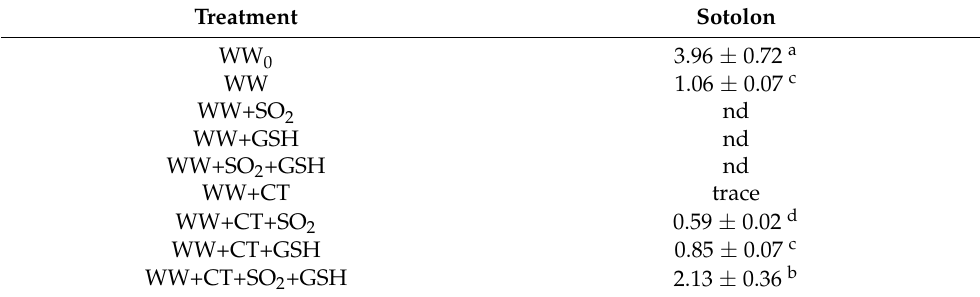
Table 5. Concentrations ( µ g/L) of sotolon determined in white wine (WW)